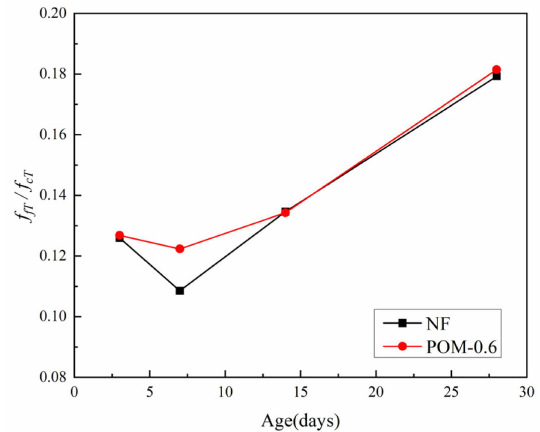
Figure 20. Relations between f fT / f f28 and concrete age.